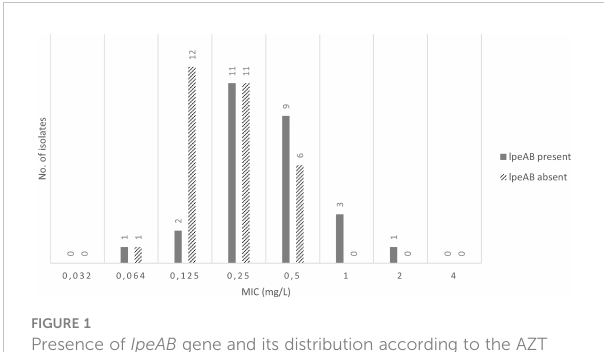
FIGURE 1 Presence of IpeAB gene and its distribution according to the AZT MIC of the 57 environmental isolates under